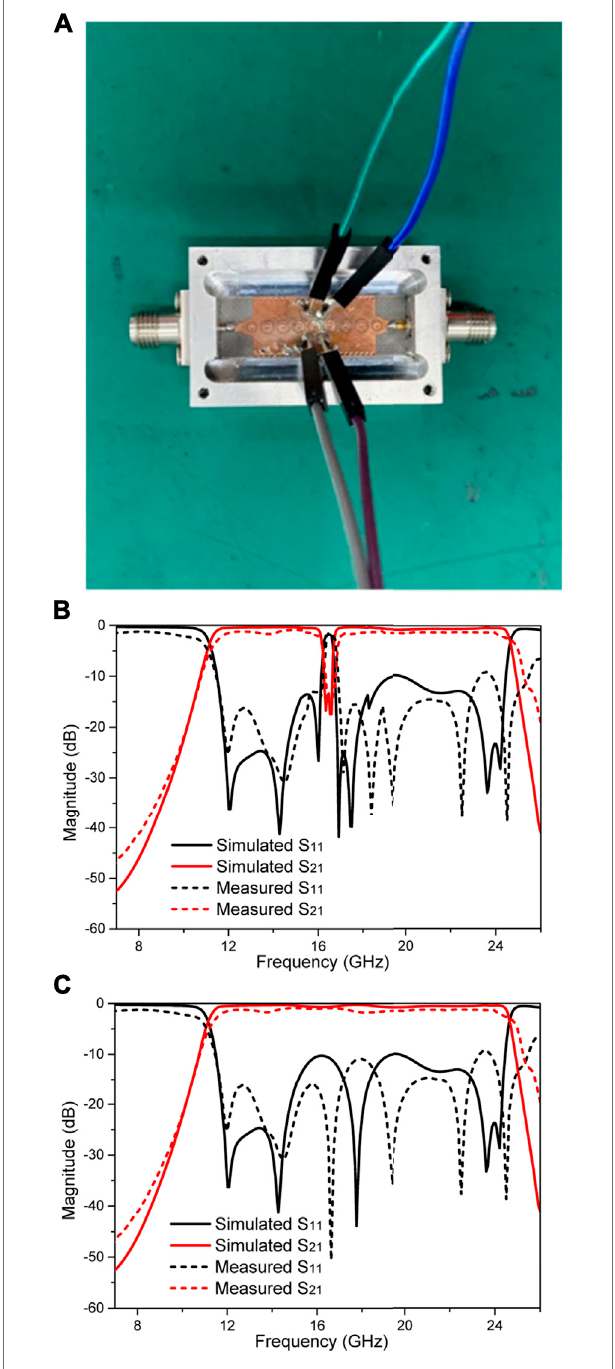
FIGURE 7 | (A) Fabricated prototype of the proposed BPF with a switchable notch band, and its simulated and measured S -parameters when the PIN diodes are under the (B) ON state and (C) OFF